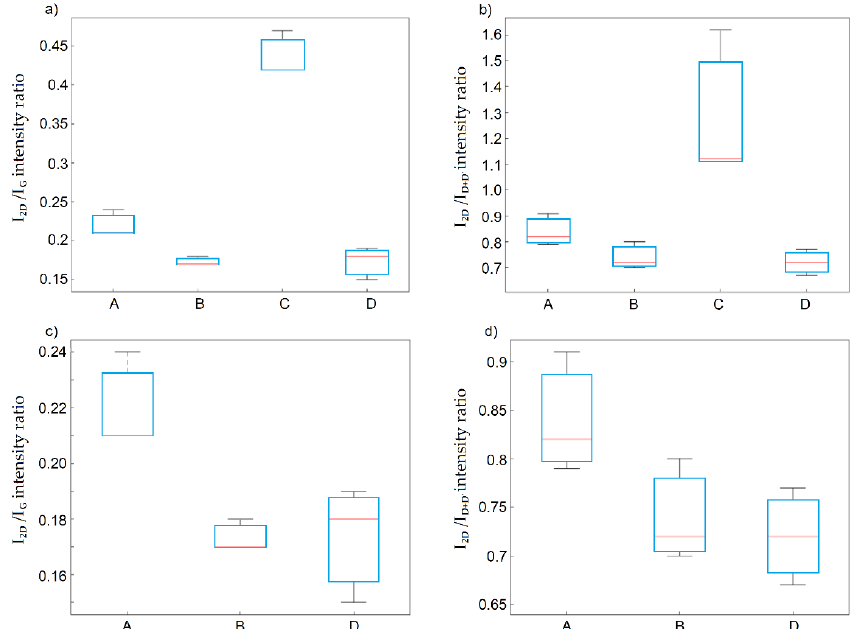
Figure 6. Box plots of: ( a ) I 2D /I G band ratio; ( b ) I 2D /I D+D’ band ratio as a function of the applied method; ( c ) I 2D /I G band ratio; ( d ) I 2D /I D+D’ after excluding method C. Analysis of data divided according to the type of graphite precursor may show that the highest I D /I G ratio values and the lowest I 2D /I G and I 2D /I D+D' ratio values were obtained for graphite oxides containing synthetic graphite. This indicates that synthetic graphite was the most susceptible to the generation of structural defects and delamination of the graphite layers during the oxidation process. However, as shown from the statistical analysis (ANOVA method), these differences were statistically insignificant (Figure 7a–c).